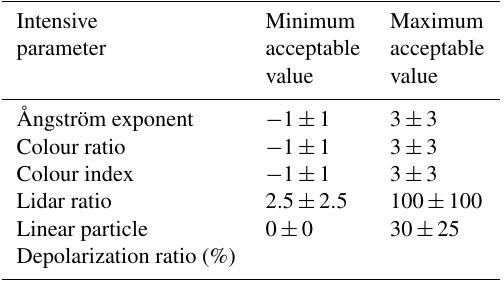
Table 5. Acceptable limits for the layer average intensive optical